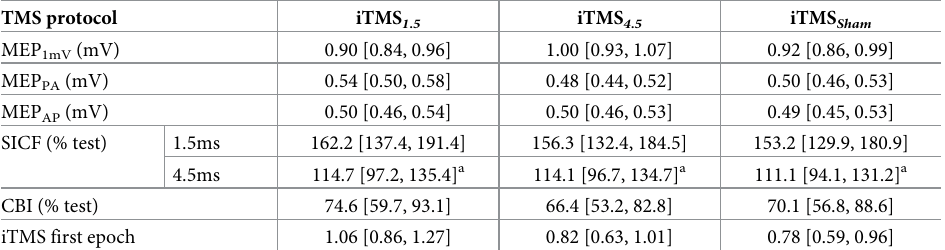
Table 2. Baseline responses of corticospinal, intracortical and cerebellar excitability between iTMS